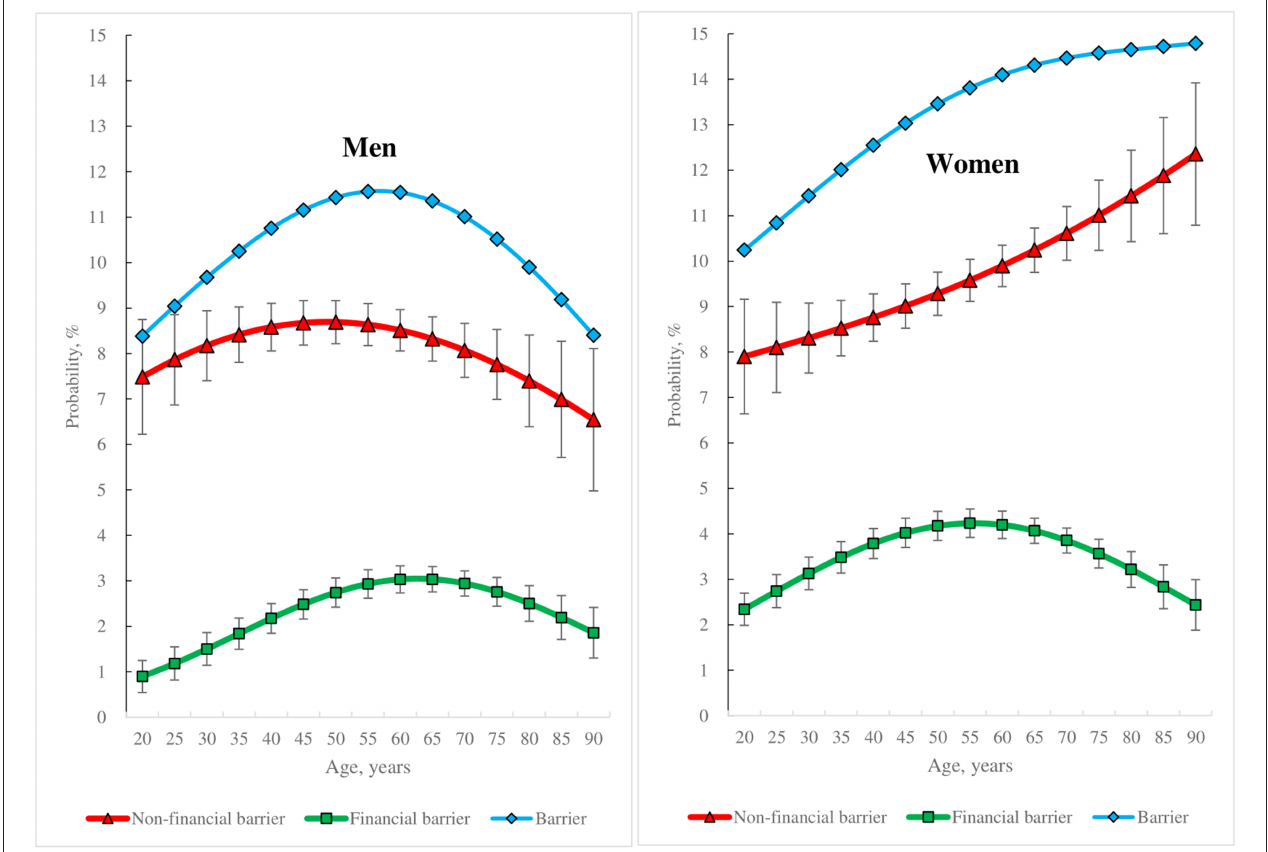
FIGURE 2 | Gender-specific differences in the average adjusted probabilities of experiencing non-financial or financial barriers that led to unmet healthcare needs across different age groups and the 95% confidence intervals.